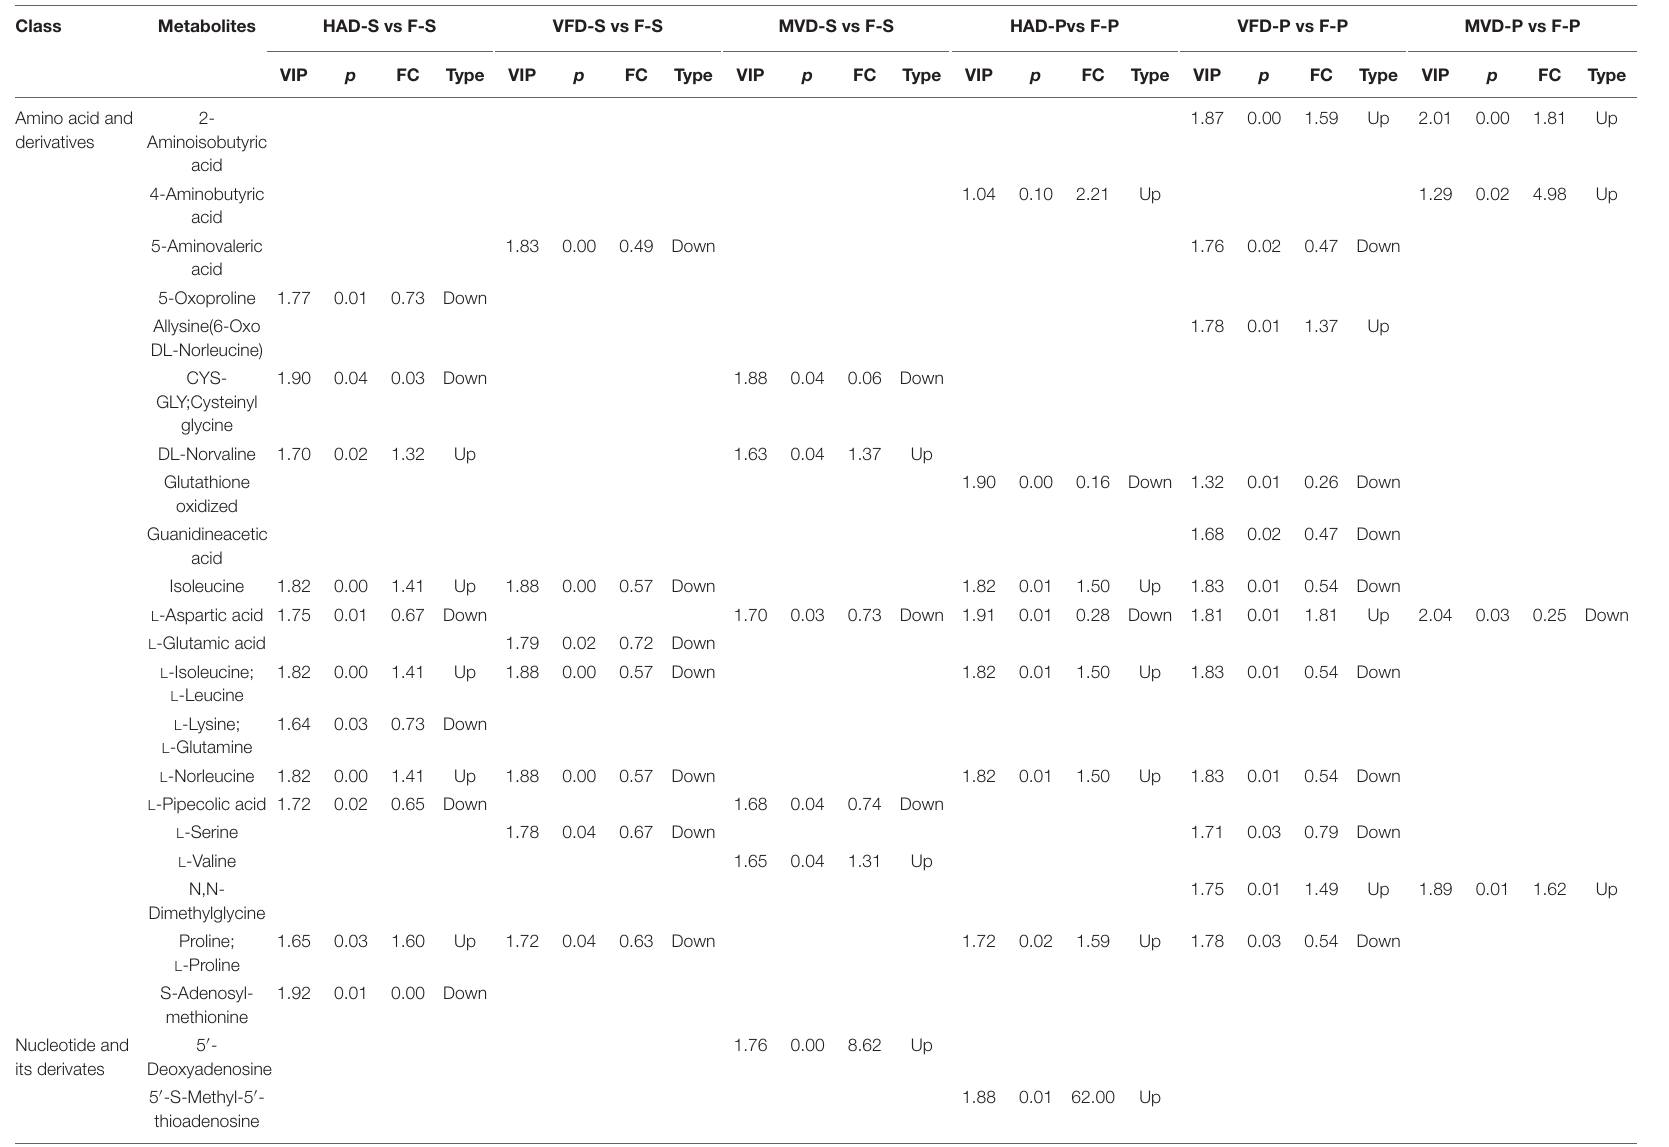
TABLE 1 | Statistics for the differentially accumulated amino acid and derivatives, nucleotides and derivatives, carbohydrates, and organic acids during the different drying methods. Class